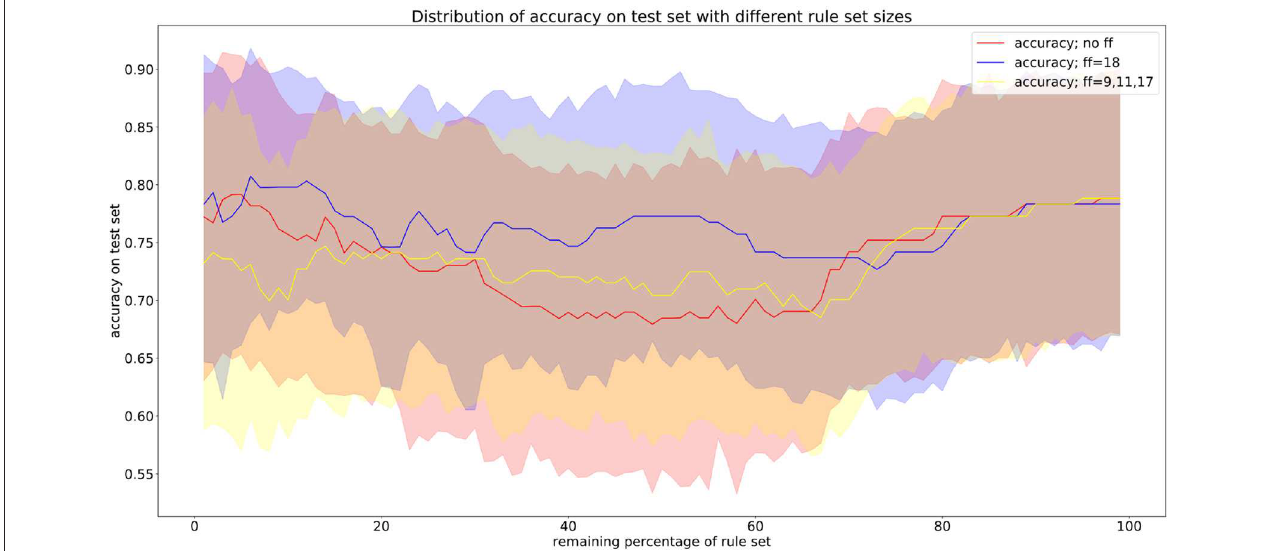
FIGURE 6 | Results from applying PECLIDES Neuro to the Speech Data Set. The line plots show accuracies depending on different rule set sizes. The x-axis indicates the percentage of rules from the original rule set, which remained in the reduced rule set. The different colors refer to different choices of favored features (ff). 100% of the rule set for this data set refers to 358 rules. The error ranges are based on 10-fold